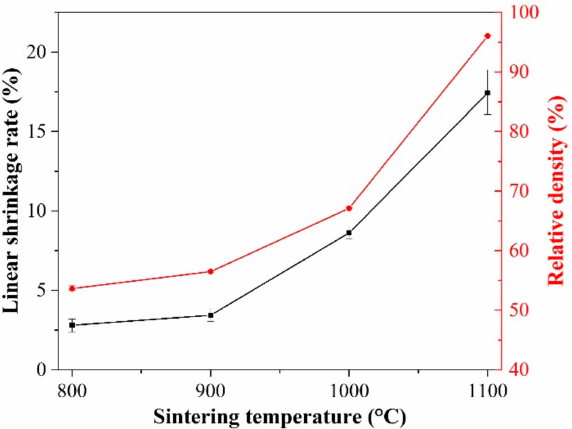
Figure 6. Shrinkage rate and relative density of the mica specimens sintered at different